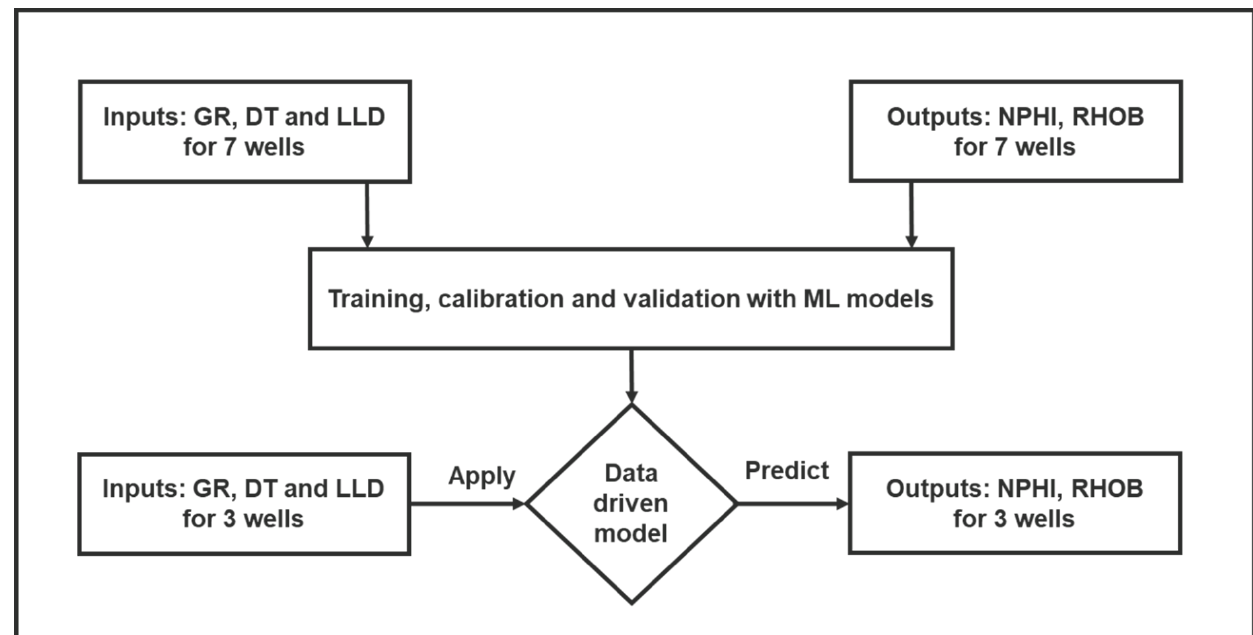
Figure 2. Workflow of a data ‐ driven model for synthetic NPHI and RHOB log prediction with supervised ML regression algorithms. One linear and three non ‐ linear ML algorithms are considered to choose the optimum prediction model.